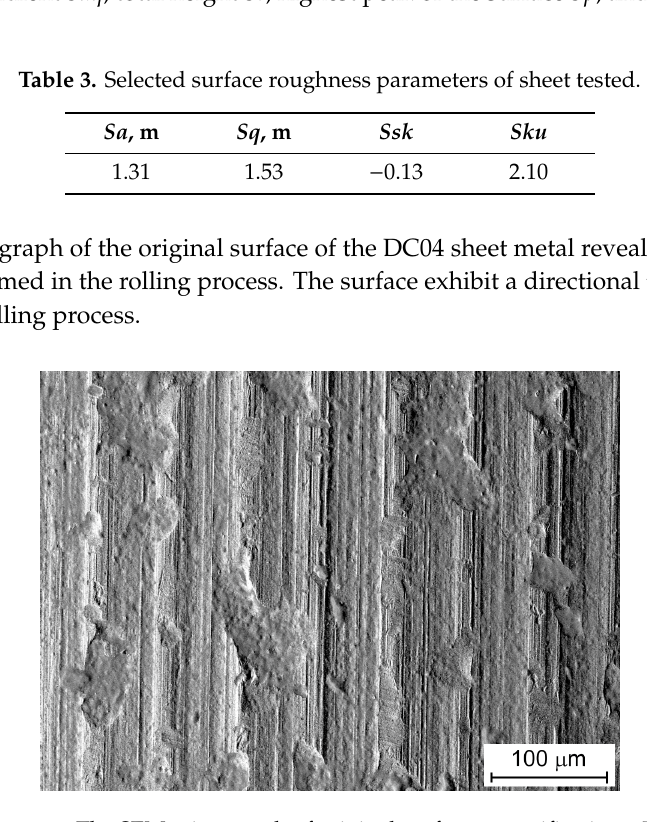
Figure 1. The SEM micrograph of original surface, magnification × 530.